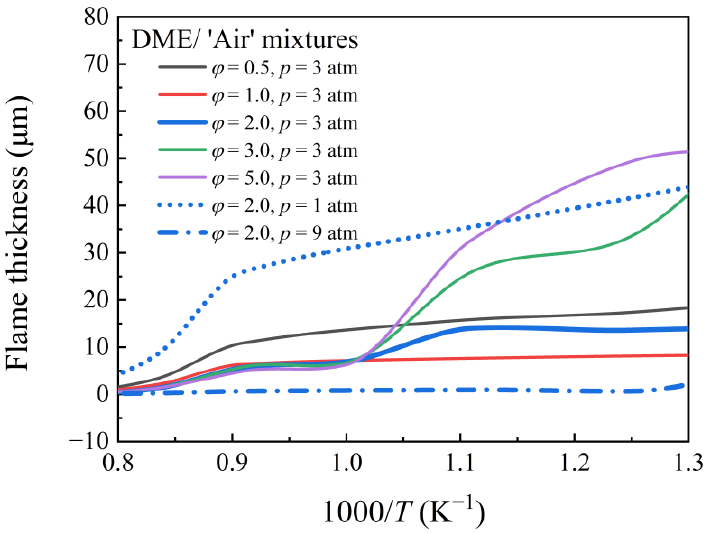
Figure 8. Flame thickness of DME/‘air’ mixtures at various equivalence ratios and different pressures.